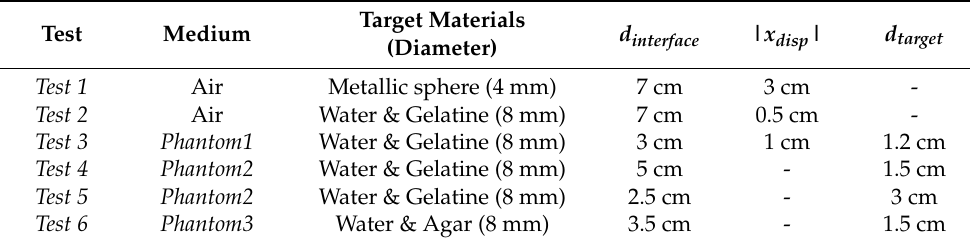
Table 3. Summary of the presented